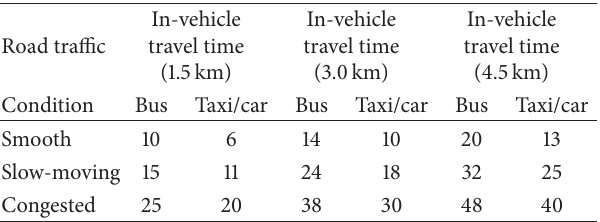
Table4:Assumedin-vehicletraveltimeindifferenttrafficcondition